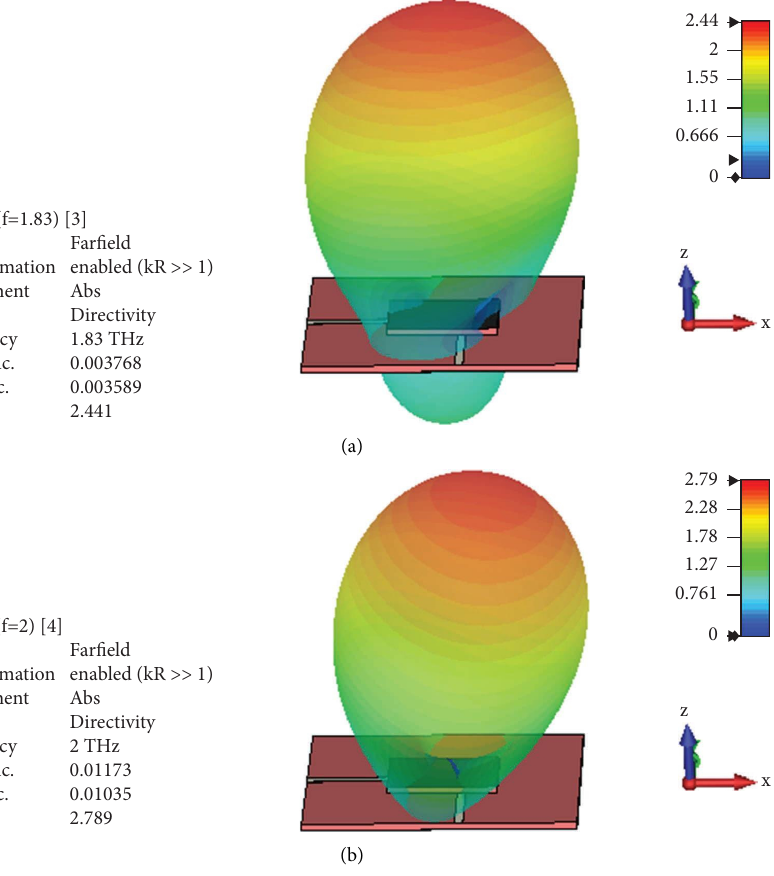
Figure 5: Radiation patterns: (a) at 1.83THz, when Port-1 is excited. (b) At 2.06THz, when Port-2 is